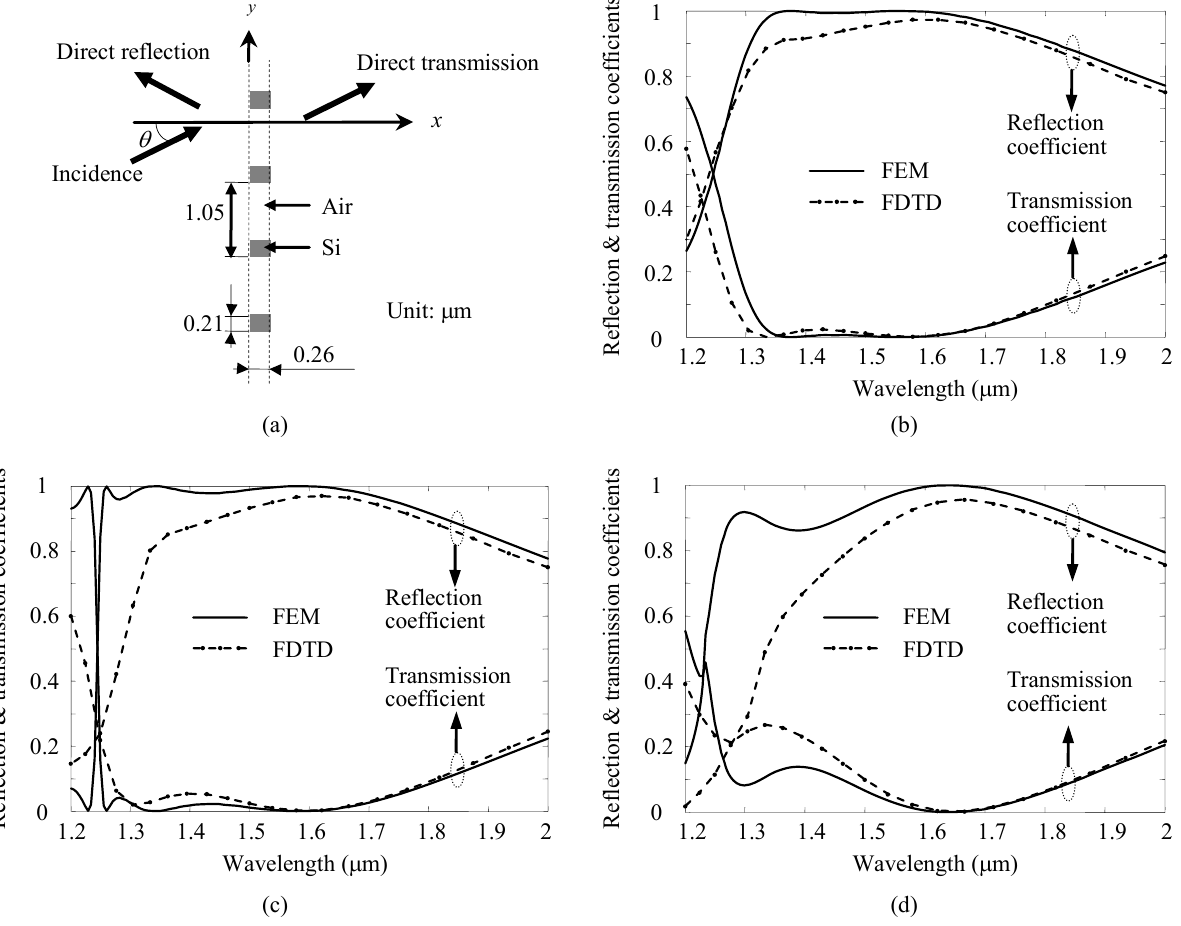
Figure 2. Numerical results for a planar GMR structure: (a) Geometry, (b) Results when θ = 0 ° , (c) Results when θ = 5 ° , (d) Results when θ = 10 °